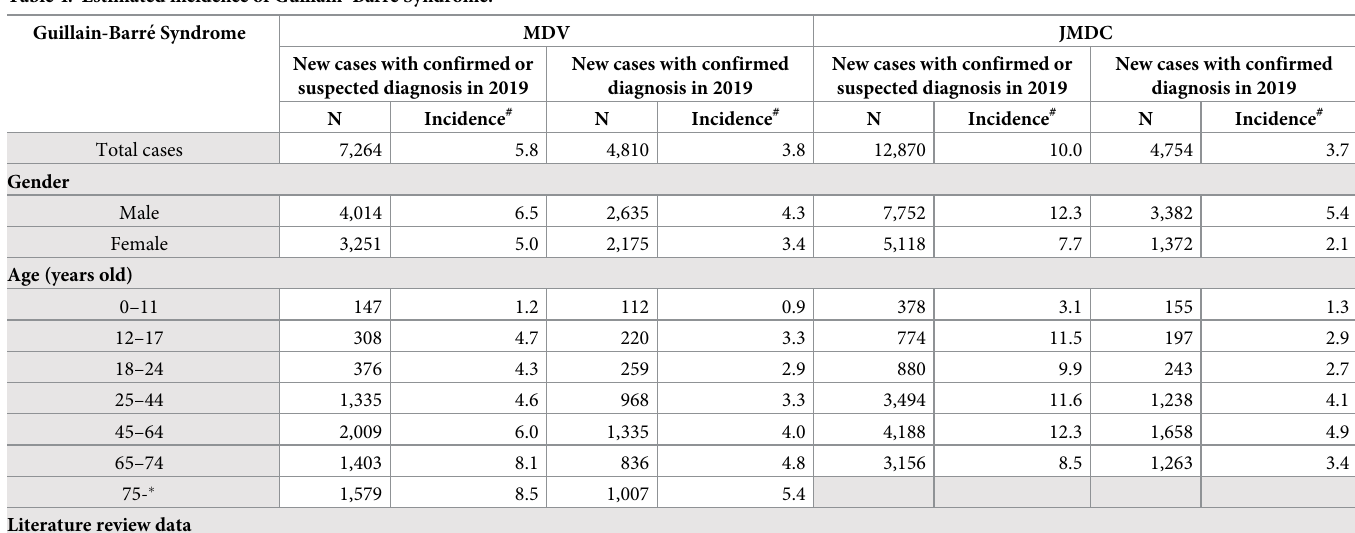
Table 4. Estimated incidence of Guillain–Barre